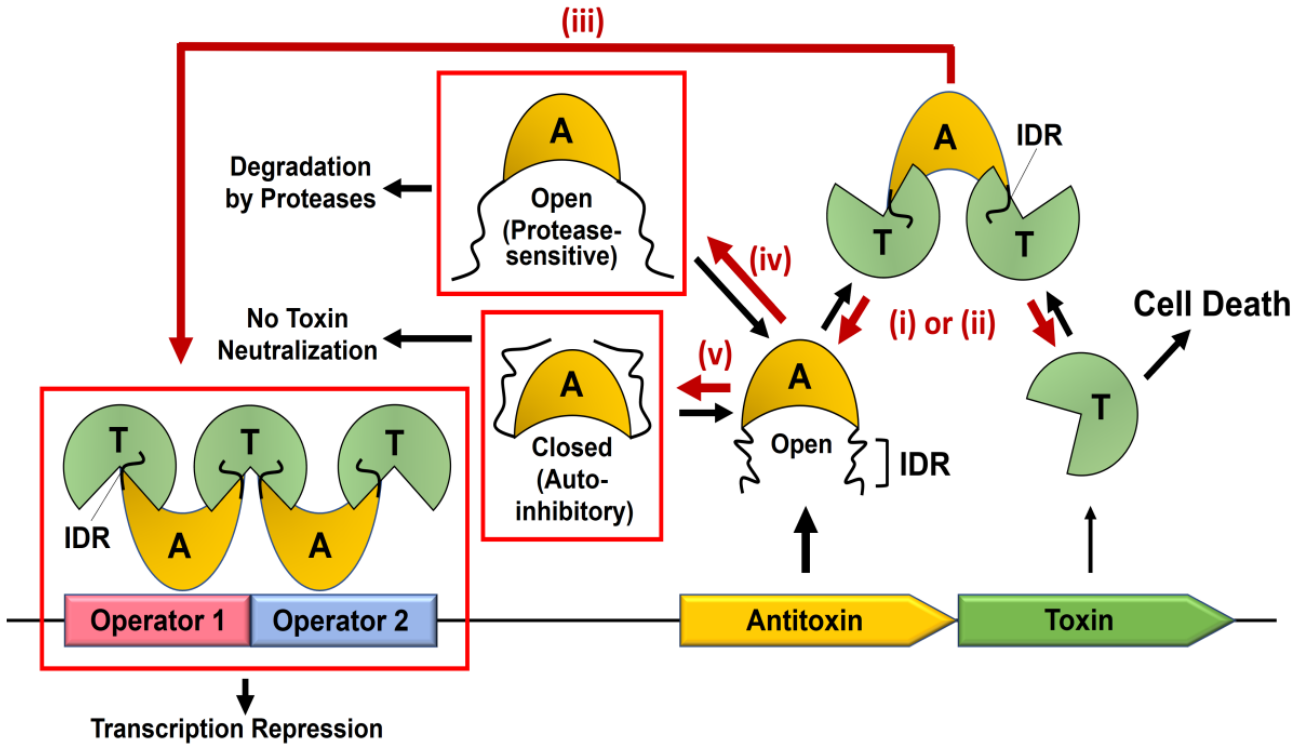
Figure 4. Proposed antimicrobial strategies utilizing the dynamics-based allostery of type II antitoxin IDRs. General mechanisms for toxin neutralization and transcription regulation in type II toxin – antitoxin systems are schematically described, and the molecular processes that can be promoted by potential antibiotics are represented by red arrows. These processes are labeled with five antibiotic strategies – (i), (ii), (iii), (iv), and (v) – as explained in the text.